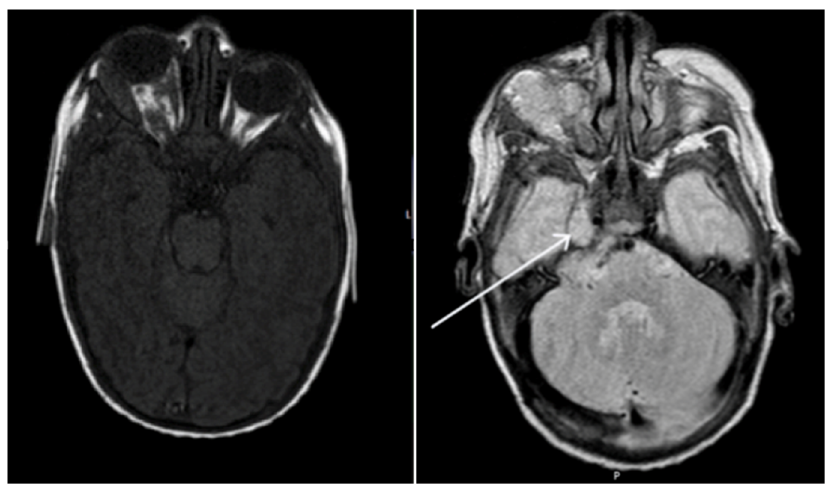
Figure 2. Axial T1 weighted and T2 weighted TSE brain magnetic resonance imaging of patient on presentation. Extensive right orbital lesion with marked proptosis. Extension of the lesion intracranially, with involvement of right Meckel’s cave (pointer) and the cerebellar pontine